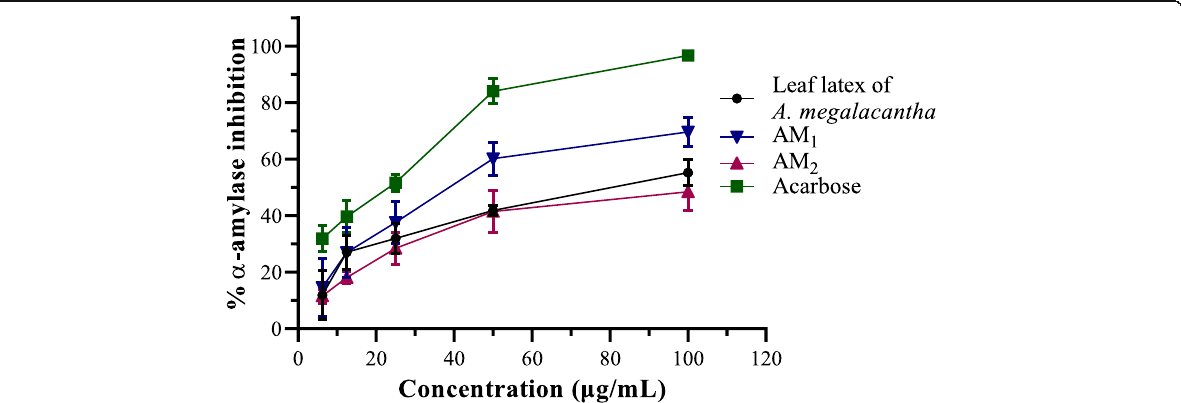
Fig. 1 Plot of percent α -amylase inhibitory effect versus different concentrations of leaves latex, AM 1 , and AM 2 of A. megalacantha Baker